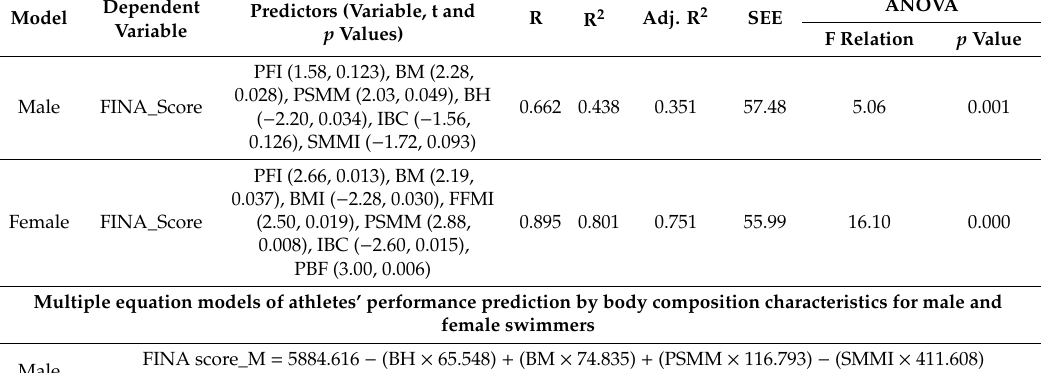
Table 3. Multivariate Regression Analysis (MRA) statistics results with the multiple equation models of athletes’ performance prediction by body composition characteristics—Model Summary.